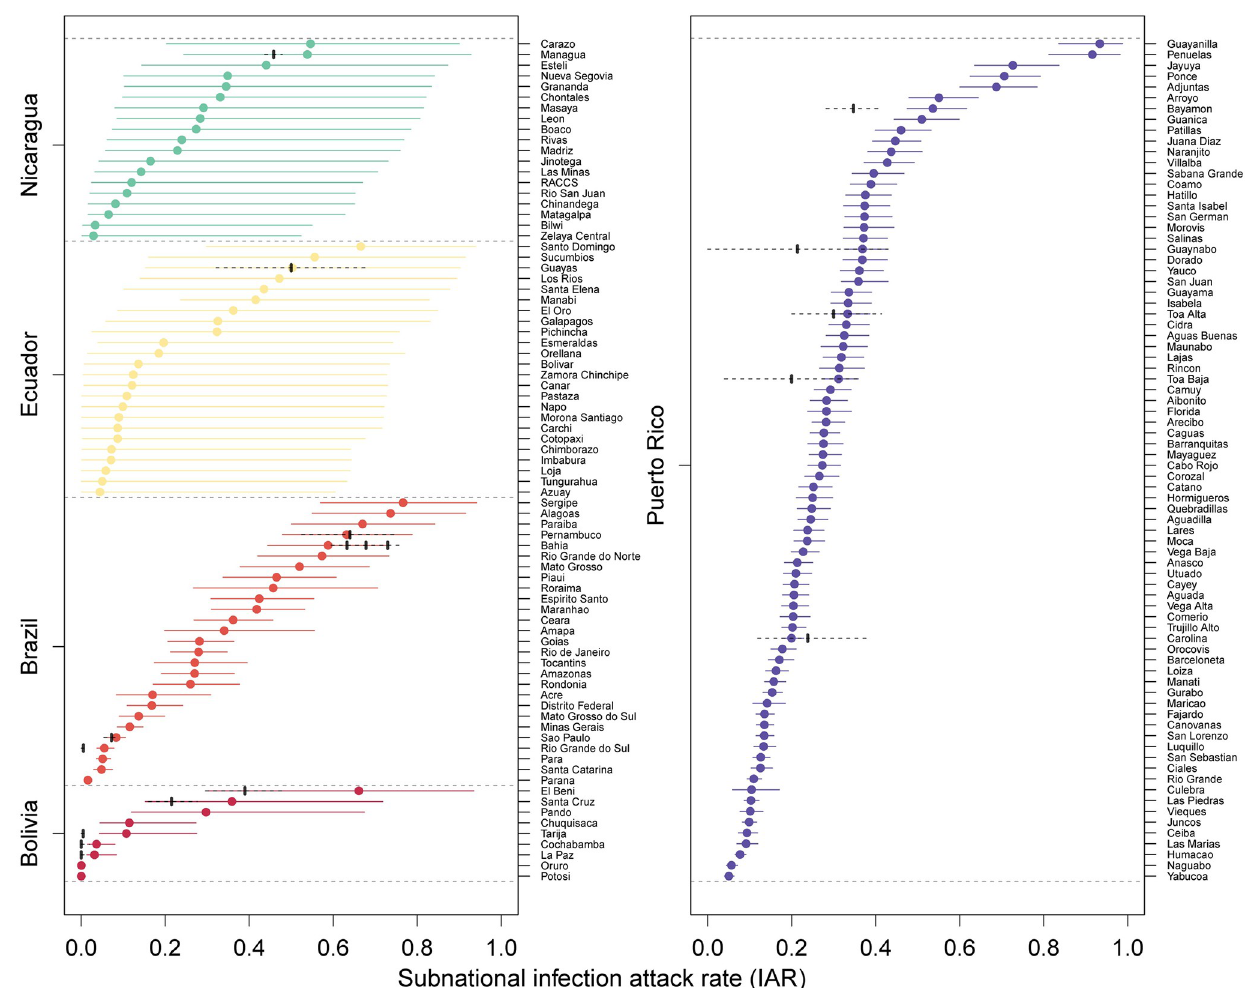
Fig 3. Posterior distribution of subnational ZIKV infection attack rates (IAR) for five different territories (Bolivia, Brazil, Ecuador, Nicaragua, and Puerto Rico). Colored circles and whiskers are the median and 95% credible intervals for each administrative unit. Black circles with dashed lines are seroprevalence estimates from the literature (see S7 Table). The dashed lines are the 95% confidence intervals for the seroprevalence estimates assuming a binomial distribution with the exception of the 95% CI estimate from [17] for Bahia, Brazil which was taken directly from their analysis.